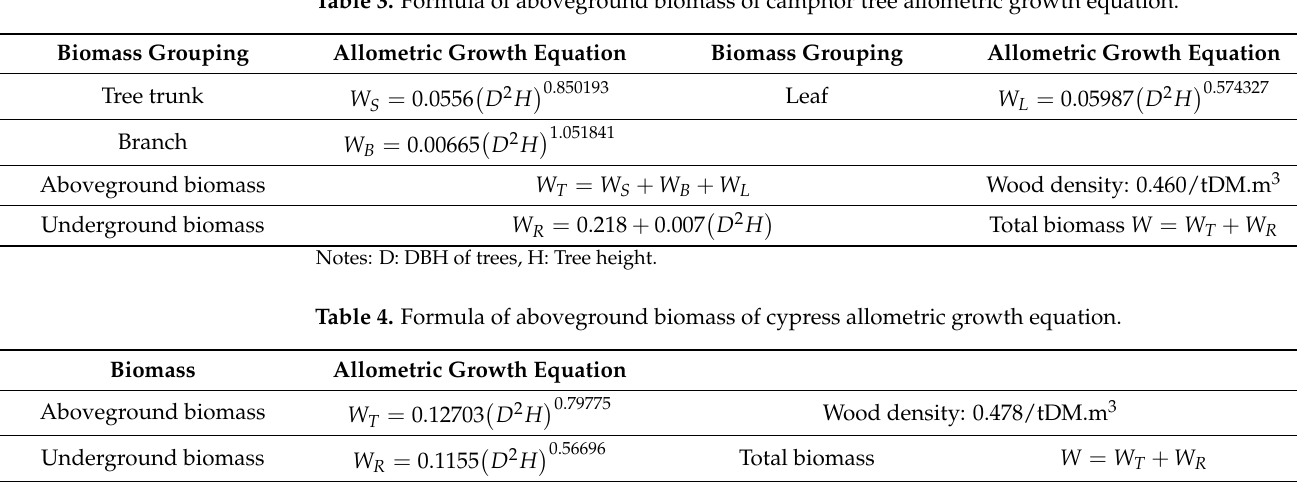
Table 3. Formula of aboveground biomass of camphor tree allometric growth equation.